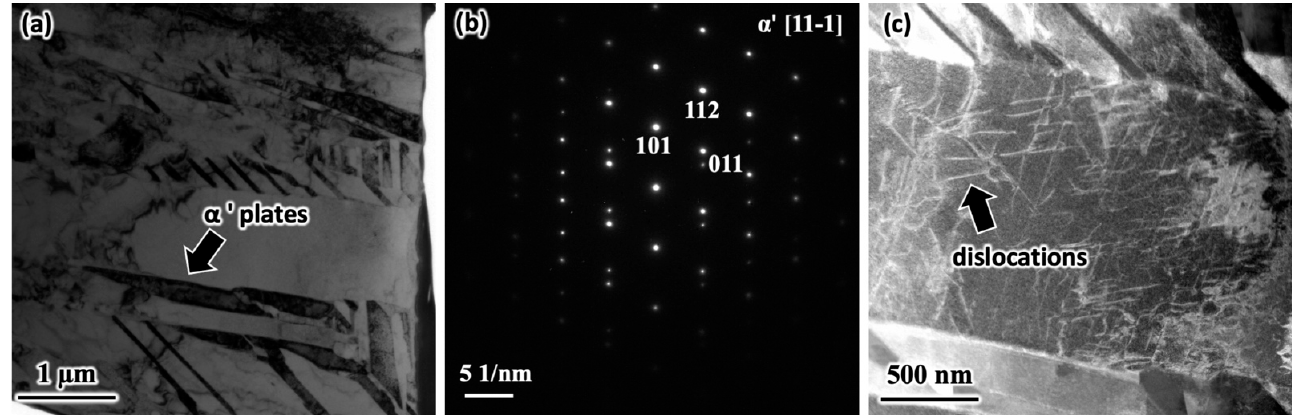
Figure 8. TEM observations from the representative ASR sample: ( a ) bright field micrograph, ( b ) SAED pattern from the α′ phase, and ( c ) HAADF STEM micrograph.